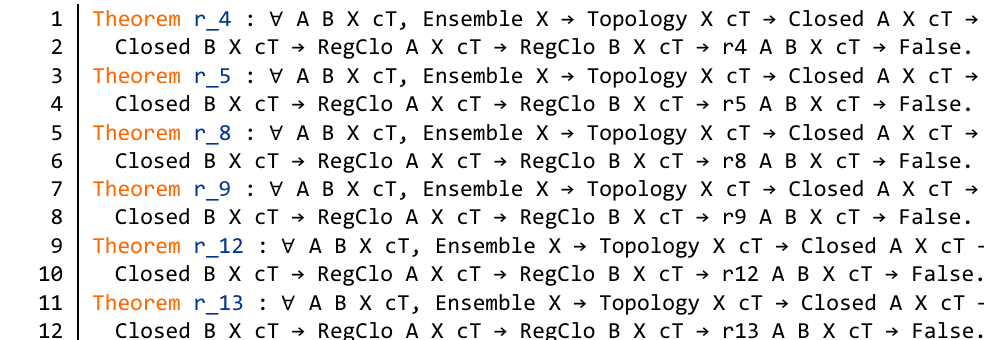
Figure 6. The formal description of Theorem